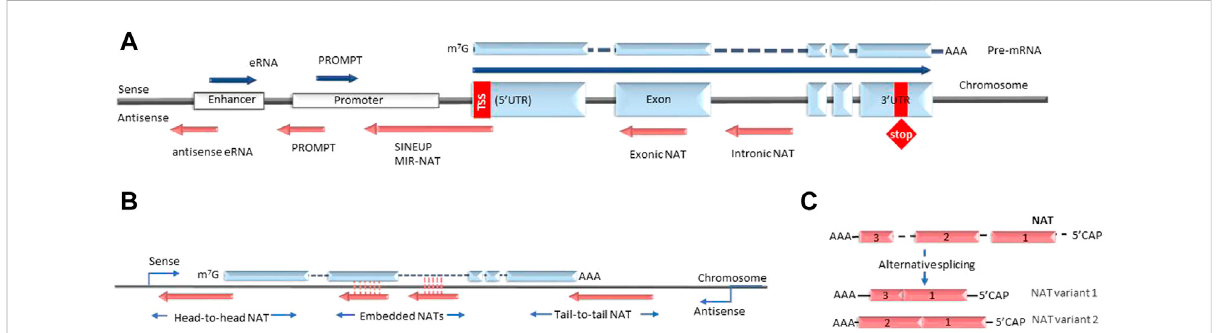
FIGURE 1 Types of antisense transcripts. (A) Enhancer RNAs and PROMPTs are transcribed bidirectionally from enhancer and promoter regions respectively. Intronic and exonic NATs are transcribed from the DNA strand opposite to the protein-coding gene under the control of different promoters (bidirectional, independent, latent etc.). SINEUPS are encoded antisense to the 5 ′ end of the mRNA and have embedded transposable elements at their 3 ′ ends. MIR-NATs are characterized by effector domains with retrotransposon-derived repeats, such as mammalian-wide interspersed repeats (MIR). (B) NATs are described as head-to-head, embedded and tail-to-tail depending on their position relative to the sense transcript. (C) Some NATs are modi fi ed with 5 ′ -caps and polyA tails and undergo alternative splicing. NAT, natural antisense transcript; eRNA, enhancer RNA; PROMPT, promoter upstream transcript; UTR, untranslated region; SINEUP, inverted SINEB2 sequence-mediated upregulating